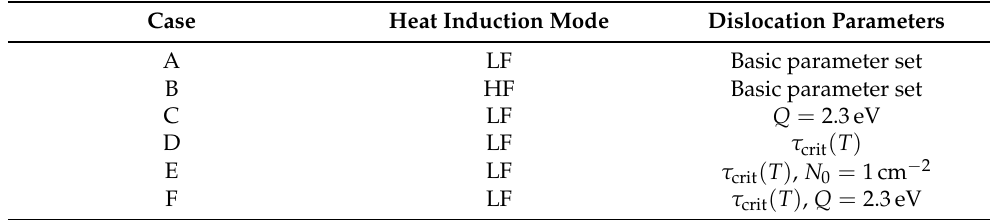
Table 1. Summary of considered